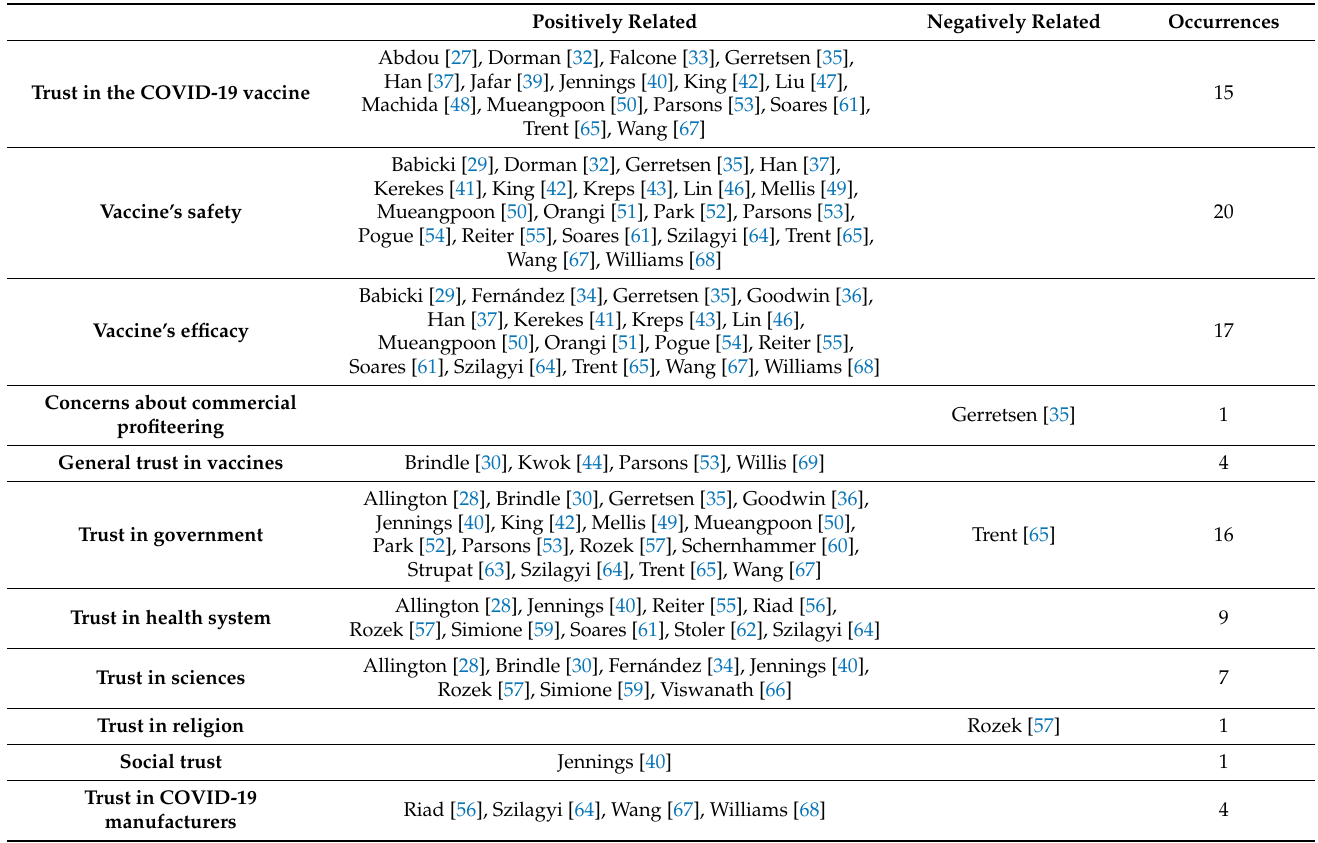
Table 2. Typologies of components of trust that have been characterized as predictors of vaccine acceptance in the considered